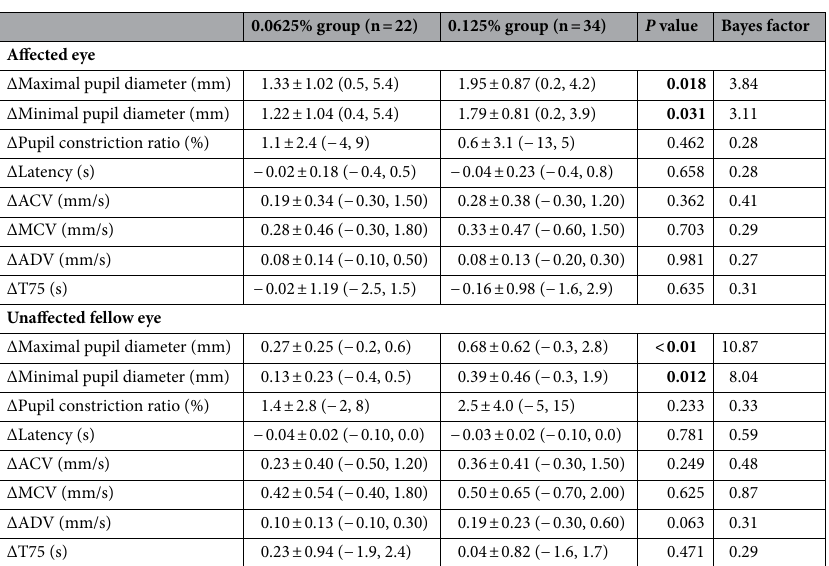
Table 2. Comparison of the changes from baseline in pupillary light reflex parameters after dilute pilocarpine instillation measured by digital pupillometry between the two dosage groups. ACV, Average constriction velocity; ADV, Average dilation velocity; MCV, Maximal constriction velocity; T75, Total time from the peak of constriction to the recovery of the pupil to 75% of maximal pupil diameter; Δ, baseline value minus post- pilocarpine test value. Data are mean ± standard deviation (min, max) unless otherwise indicated. P values in boldface indicate statistical